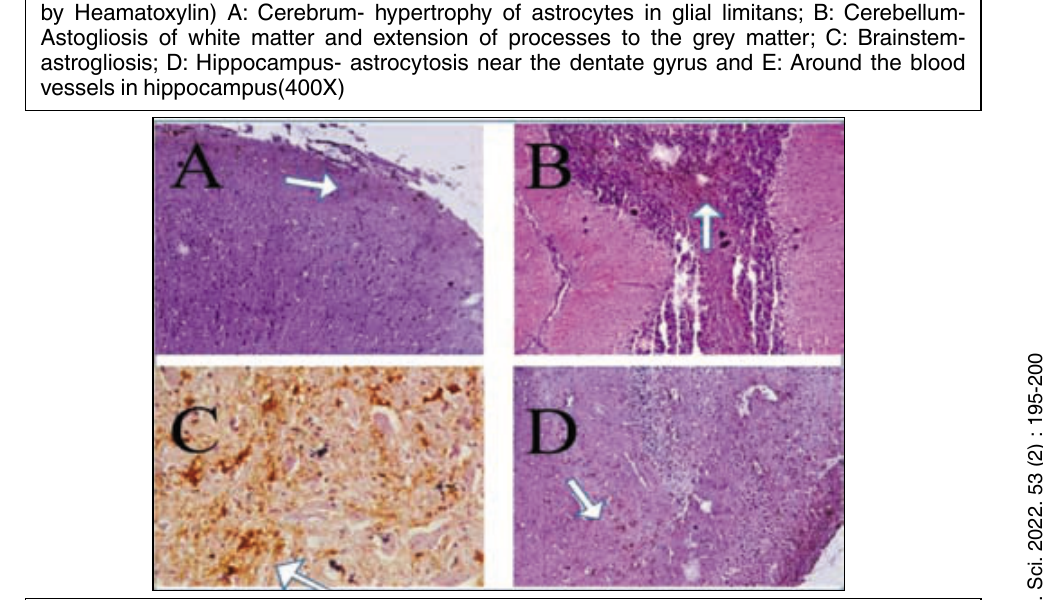
Fig. 2. GFAP reactivity in paralytic form of rabies (DAB stained IHC sections counter stained by Heamatoxylin) A: Cerebrum- mild hypertrophy of astrocytes in glial limitans (100X); B: Cerebellum- Moderated astogliosis of white matter and mild extension of processes to the grey matter (100X); C: Moderate astrogliosis of hippocampus (400X); D: Astrogliosis in the Brain stem